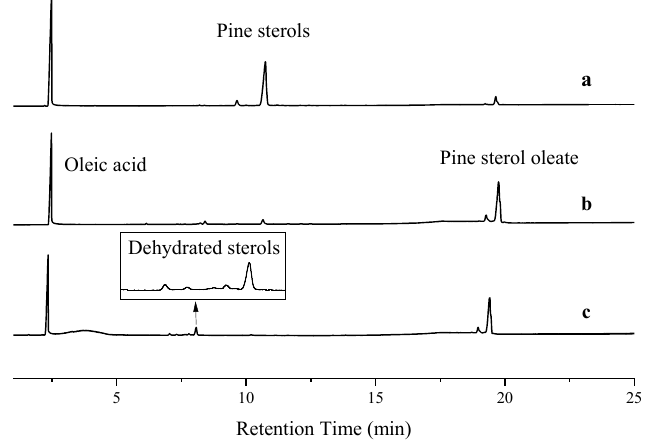
Figure 1. GC chromatogram of the reaction mixture using different catalysts. Reaction conditions: 2 mmol pine sterols, 4 mmol oleic acid, 7% catalyst (based on the mass of pine sterols), 120 °C, 5 h. Catalyst: ( a ) None; ( b ) DES; ( c ) PTSA.